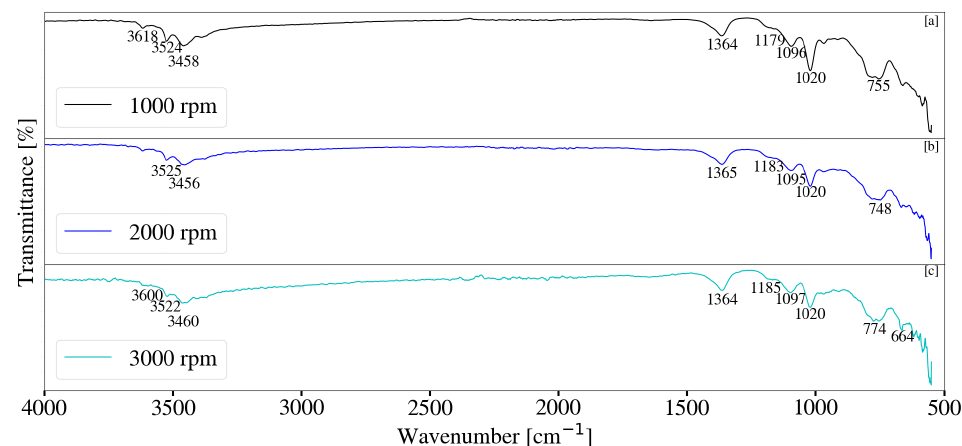
Figure 15. ( a ) FT-IR analysis for Mg-Al LDH sample synthesised at a rotational speed of 1000 rpm (S13). ( b ) FT-IR analysis for Mg-Al LDH sample synthesised at a rotational speed of 2000 rpm (S14). ( c ) FT-IR analysis for Mg-Al LDH sample synthesised at a rotational speed of 3000 rpm (S15). Milling parameters were set at a retention time of 1 h, jacket water inlet temperature of 50 °C, media size of 2 mm and a solids loading of